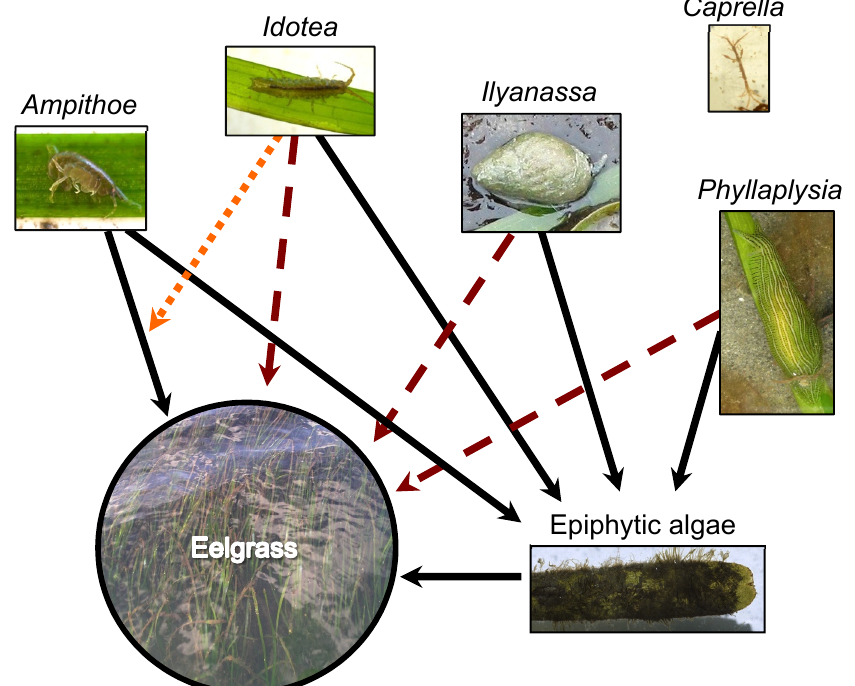
Figure 5. Conceptual diagram of interactions among grazer species, eelgrass, and epiphytic algae as observed in the mesocosm experiment. Solid black lines indicate a negative effect of one species on another. Dashed red lines indicate an indirect positive effect of one species on another. The dotted orange line indicates the reduction in Ampithoe ’s negative effects on eelgrass with Idotea present, which may be mediated by Idotea -induced changes in eelgrass palatability. All photos by the authors. Organisms not shown to